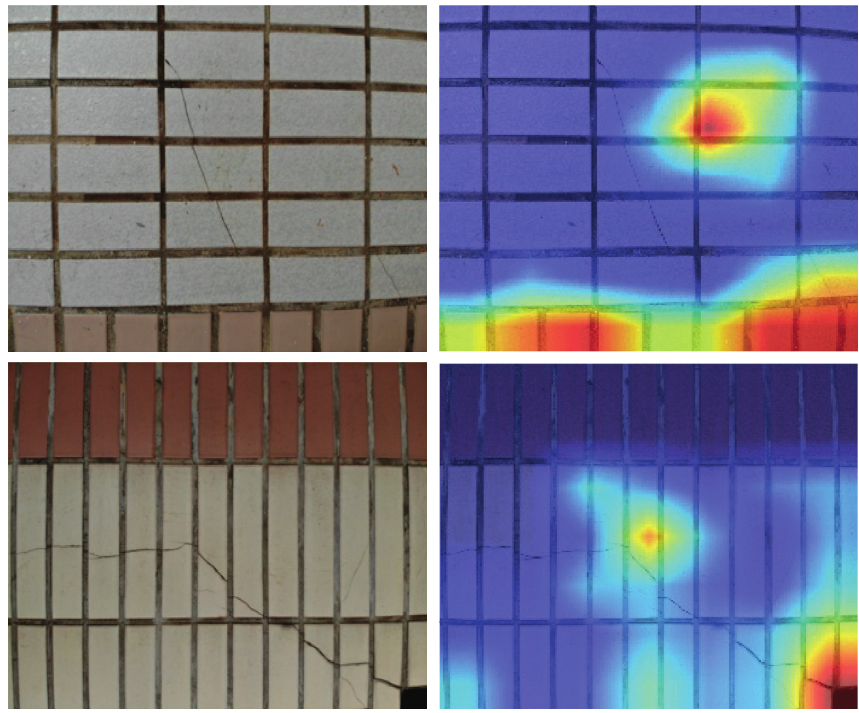
Figure 10: Cracking classified as spalling: comparison between original images and